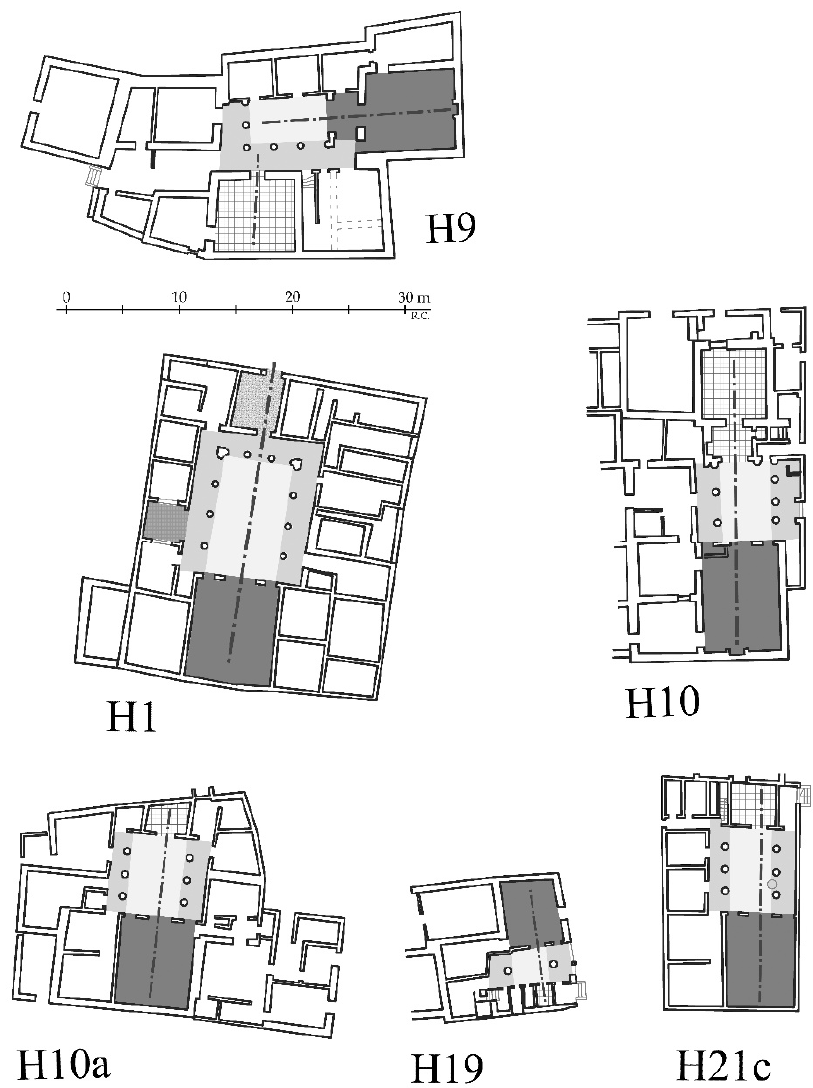
Figure 3. Marina el-Alamein. Schemes of the most well-developed plans of homes (drawing Rafał Czerner).